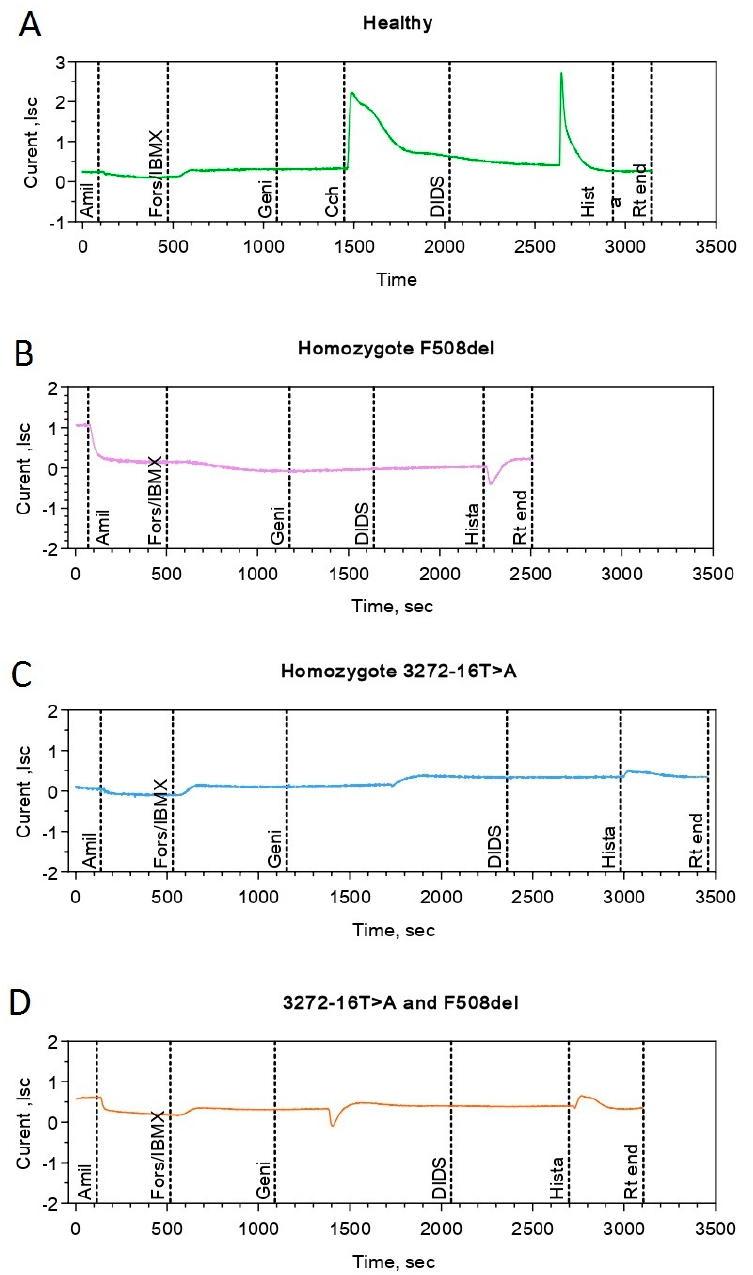
Figure 1. Intestinal current measurement (ICM) for patients carrying the genetic variant c.3140-16T>A. Note: ( A ) Healthy individual (control). The addition of amiloride caused a decrease